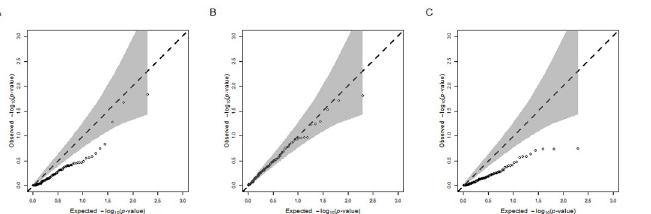
Fig 2. QQ-plots visualizing the distribution of p -values resulting from the likelihood ratio tests (LRTs) for the presence of the indirect effect ( a 2 + g 2 ) b 2 in different scenarios. Panel (a): Mediator M does not have a genetic component, but has an effect on outcome Y (( a 2 + g 2 ) = 0, b 6¼ 0); Panel (b): Mediator M has a genetic component, but does not have an effect on outcome Y (( a 2 + g 2 ) > 0, b = 0); Panel (c): Mediator M does not have a genetic component, nor an effect on outcome Y (( a 2 + g 2 ) = 0, b =